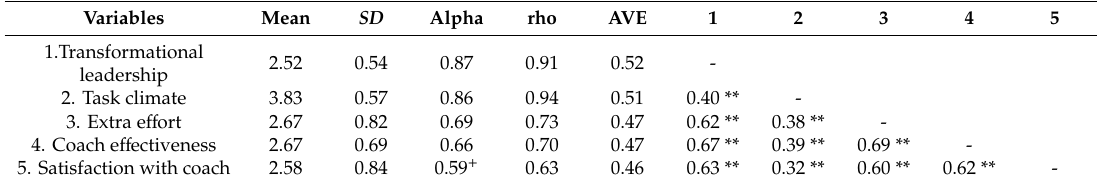
Table 1. Descriptive statistics, internal consistency, and Pearson correlation coe ffi cients for the study